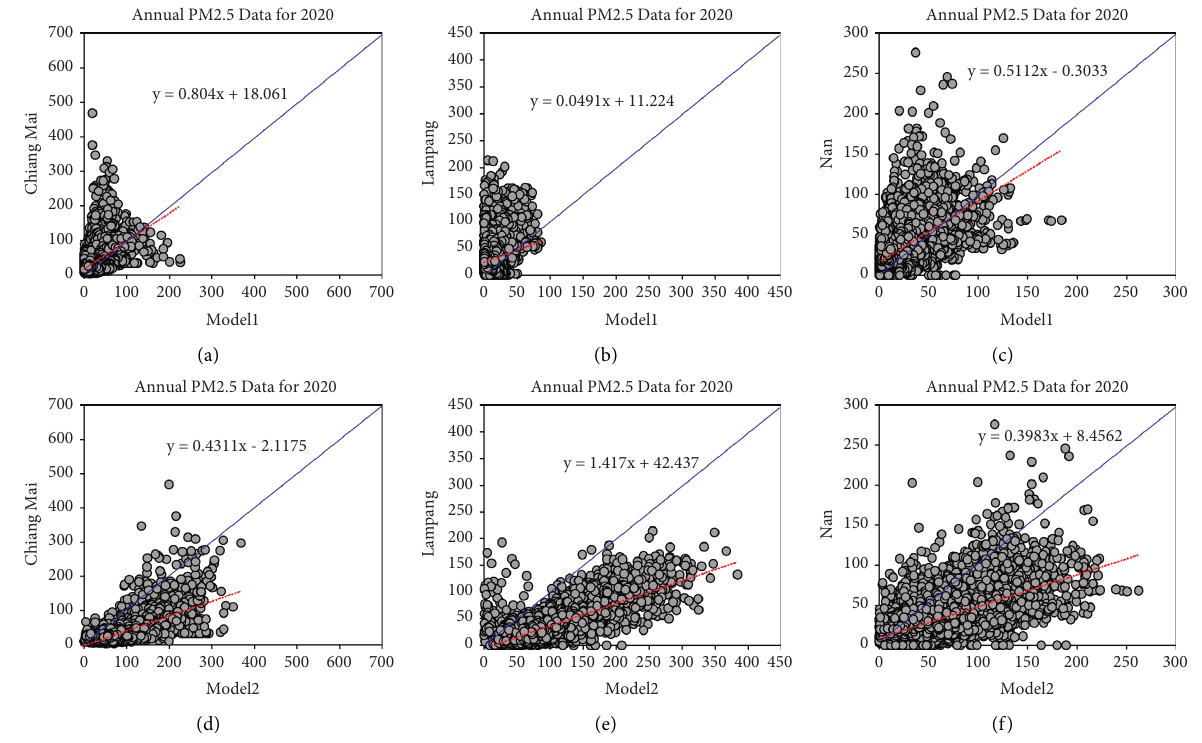
Figure 2: Fitting results of annual PM 2.5 data for (a–c) model 1 (generic) and (d–f) model 2 (multivariate linear regression).